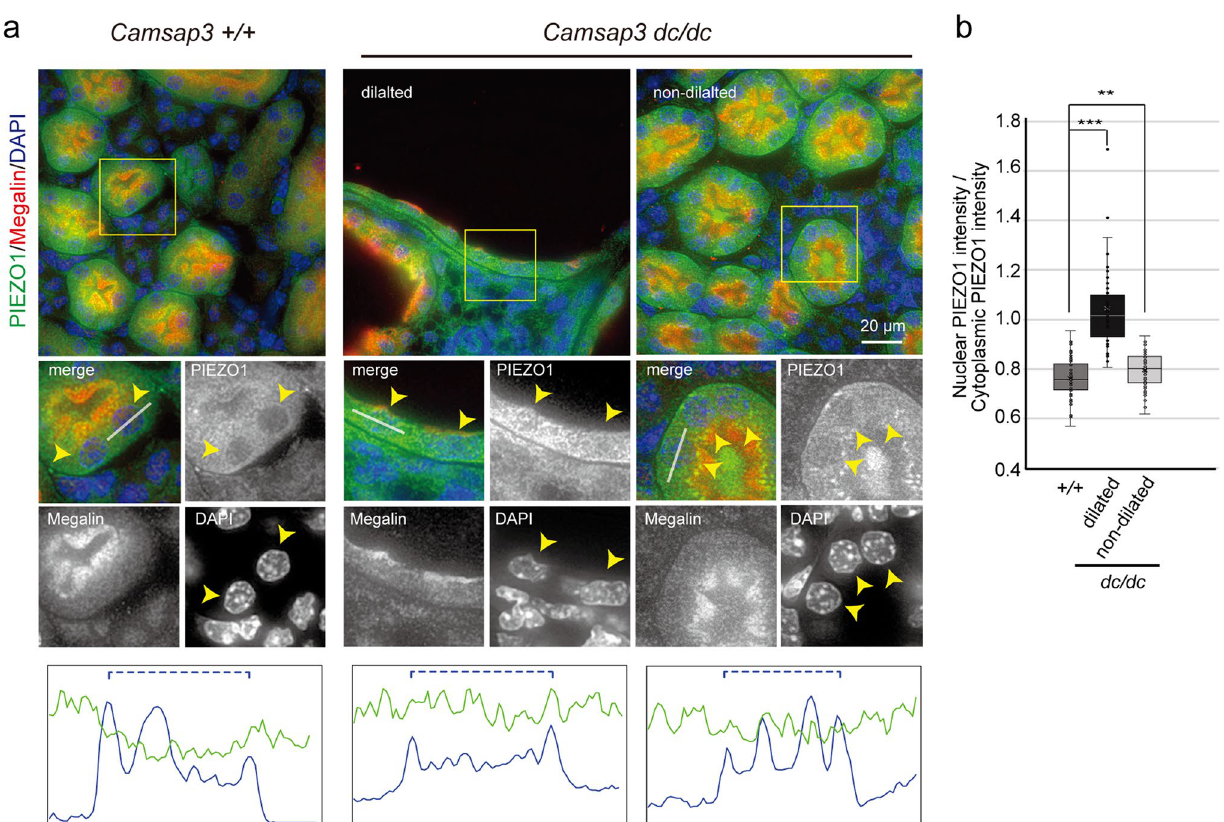
Figure 6. Change in PIEZO1 distribution in Camsap3 dc/dc PCTs. ( a ) Immunostaining for PIEZO1, Megalin, and DAPI in WT and Camsap3 dc/dc kidneys at P22. Fluorescence signals of DAPI and PIEZO1 were scanned along the line drawn in the enlarged images, and the spatial changes in fluorescence intensity are shown in blue for DAPI and green for PIEZO1. Dashed lines indicate the approximate area of the nucleus. Arrowheads indicate the position of the nucleus in representative cells. ( b ) Ratio of nuclear piezo1 intensity to cytoplasmic piezo1 intensity [+ / + , n = 66 cells; dc/dc (dilated), n = 44 cells; dc/dc (non-dilated), n = 81 cells]. Box plots indicate first quartile, median, and third quartile values. *** p < 0.001, ** p < 0.01, t-test. See also Figure